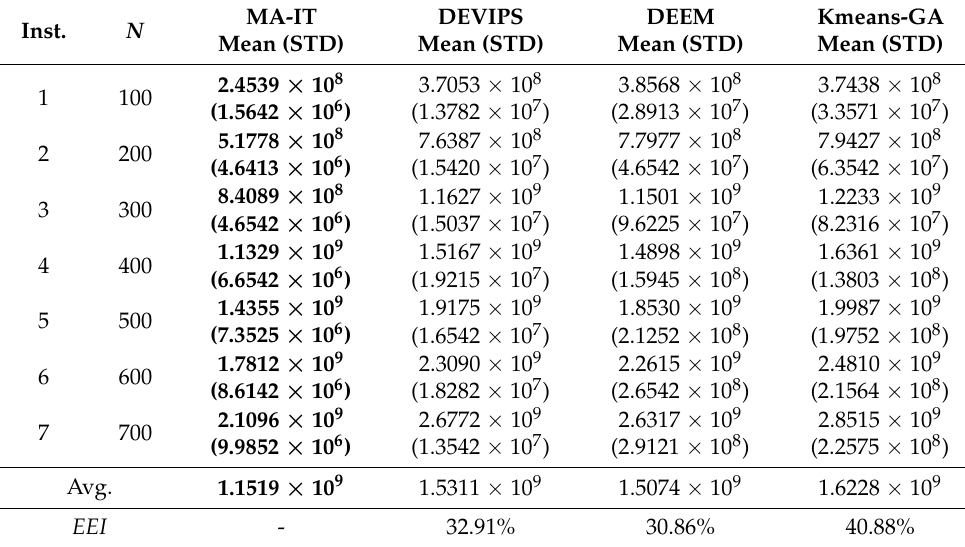
Table 2. The results (energy consumption) of all algorithms (J). Inst. N